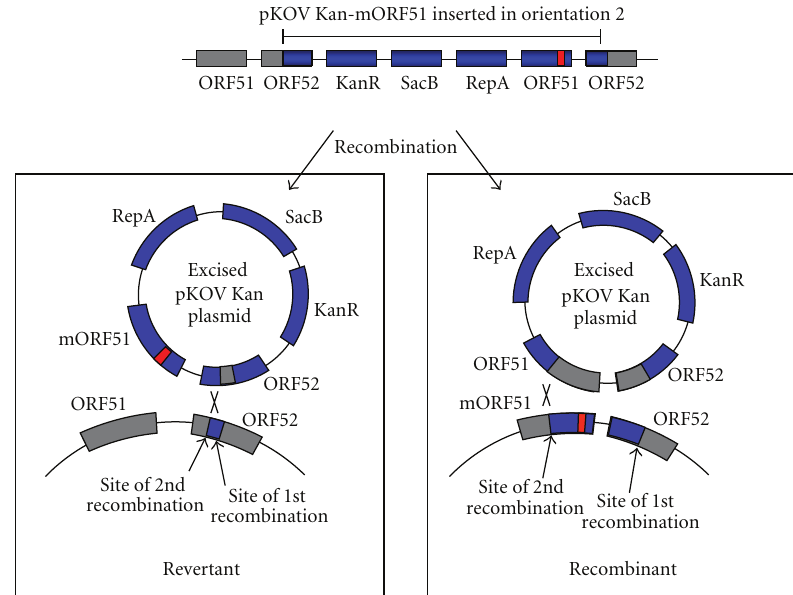
Figure 5: Schematic describing the resolution of cointegrant clones. Cointegrants which have the pKOV Kan-mORF51 plasmid (shown in blue) inserted into the HVS genome (shown in grey) undergo a second recombination event, resulting in two possible outcomes. If the recombination site is in the same homology region as the first recombination, the intact pKOV Kan mORF51 plasmid is excised, forming a revertant. However, if this recombination occurs in the opposite homology region to the previous recombination event, the mutated region (shown in red) remains in the HVS genome, while the wild-type ORF51 is incorporated into the pKOV Kan plasmid.